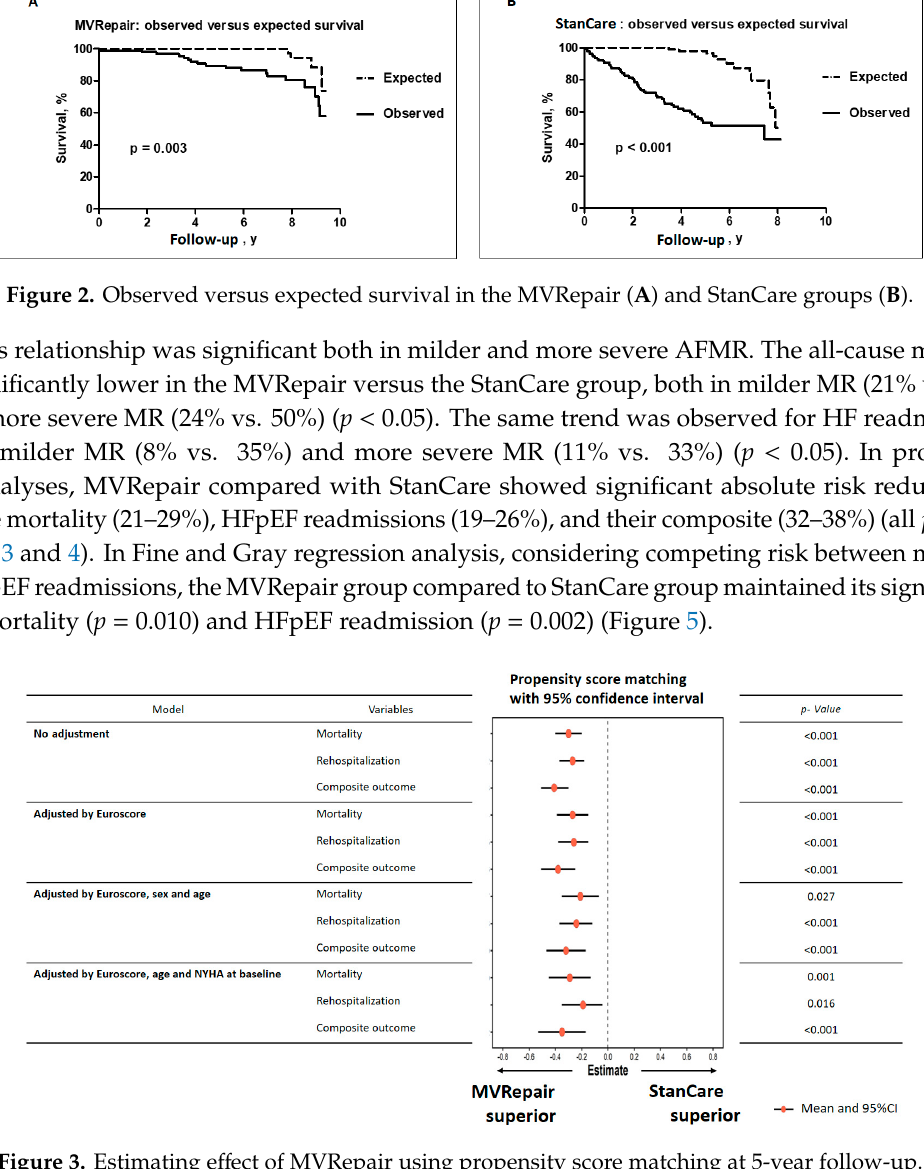
Figure 3. Estimating effect of MVRepair using propensity score matching at 5-year follow-up.